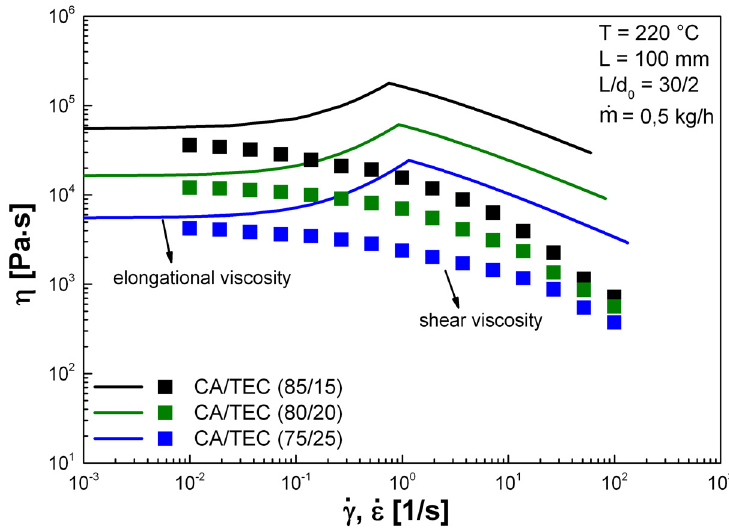
Figure 9. ( a ) Influence of TEC content on the stress curves σ as a function of draw ratio V ; ( b ) Initial slope of the stress curves σ via mean drawdown force F